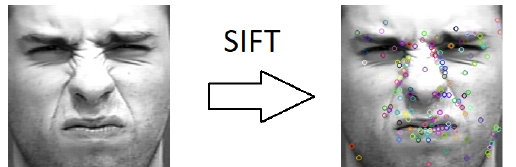
Figure 19. SIFT features of a face from the CK+ database.